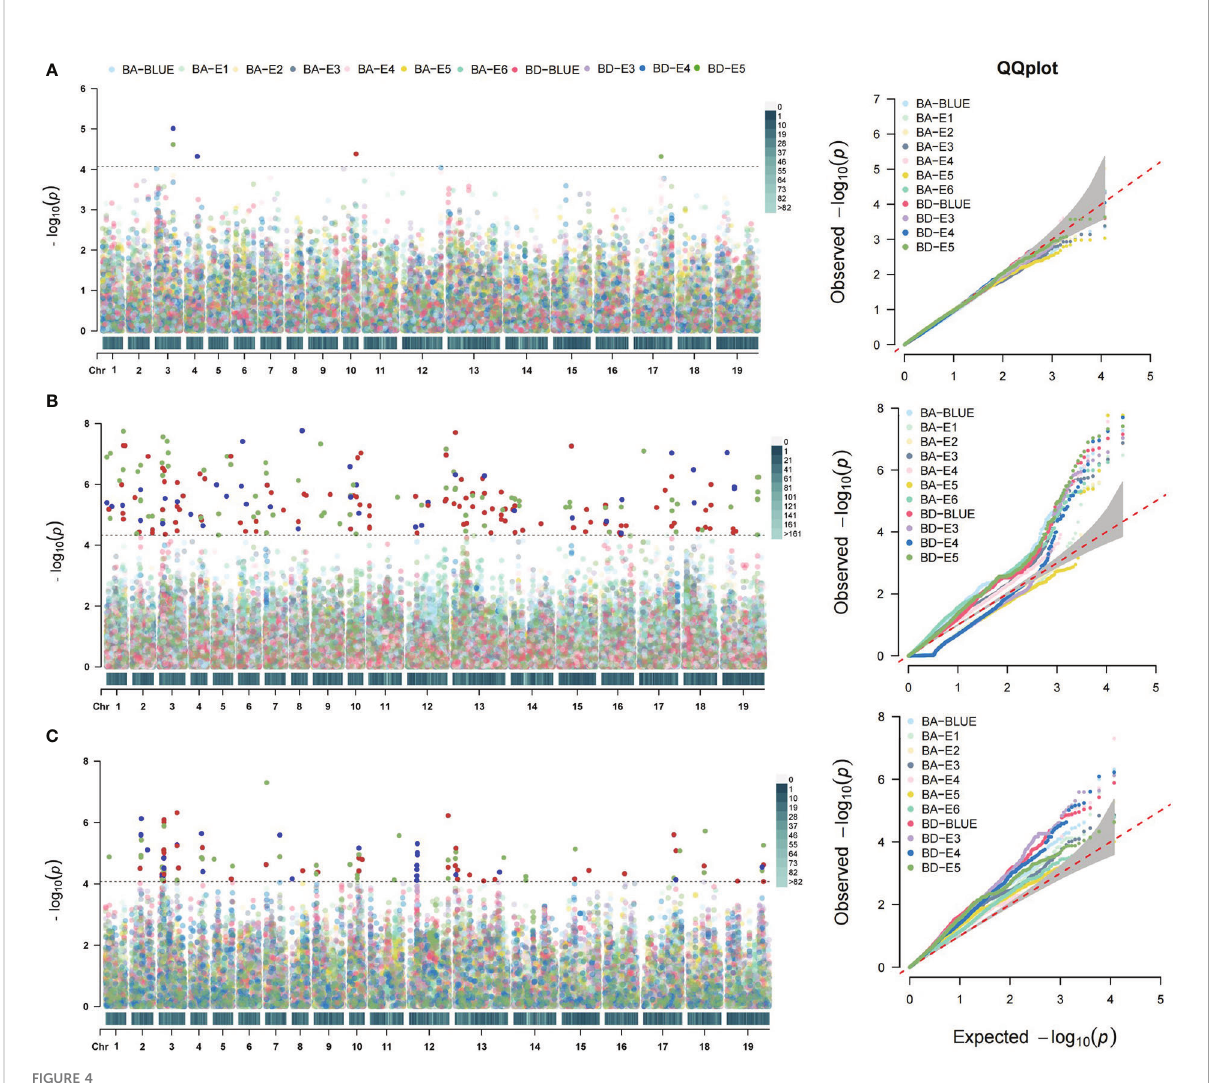
FIGURE 4 Genome-wide association analysis of BA and BD. (A) Manhattan (left) and Q-Q plots (right) of BA and BD using MLM model. (B) Manhattan and Q-Q plots of BA and BD using mrMLM model. (C) Manhattan and Q-Q plots of BA and BD using FarmCPU model. The different colors distinguished the different environments, as shown in the legends. The horizontal dotted line indicates the signi fi cance threshold [ – log10 ( p ) =